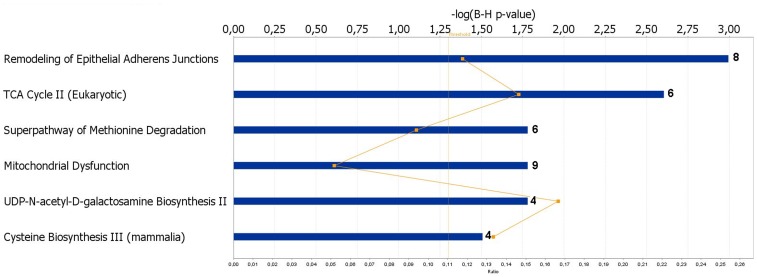
Canonical pathways of DEGs in liver from boars with high and low skatole using Ingenuity Pathways Analysis software.The most significant functional groups (p < 0.05) are presented graphically. The bars represent the p-value on a logarithmic scale for each functional group.